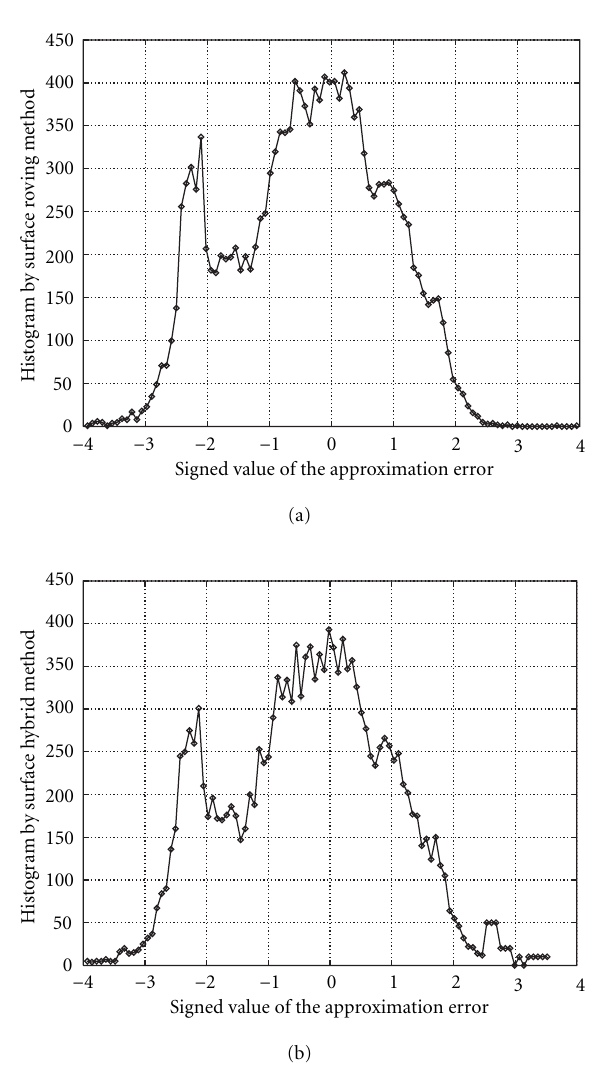
Figure 6: Histogram of the approximation error between the Bunny mesh models. (a) Result of applying exact measure by sur- face roving (original surface roving). (b) Result of applying asymp- totic measure by viewpoint sampling plus surface roving (coopera- tive method).